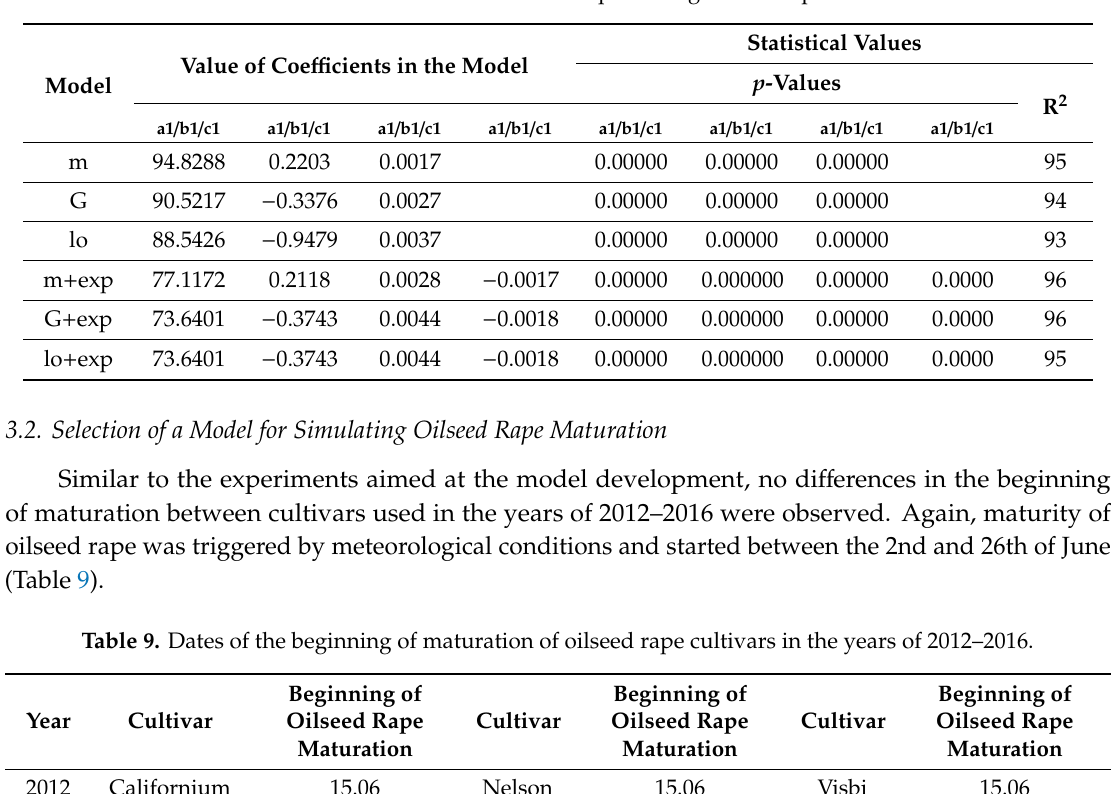
Table 8. Parameters of the models used for predicting oilseed rape maturation.